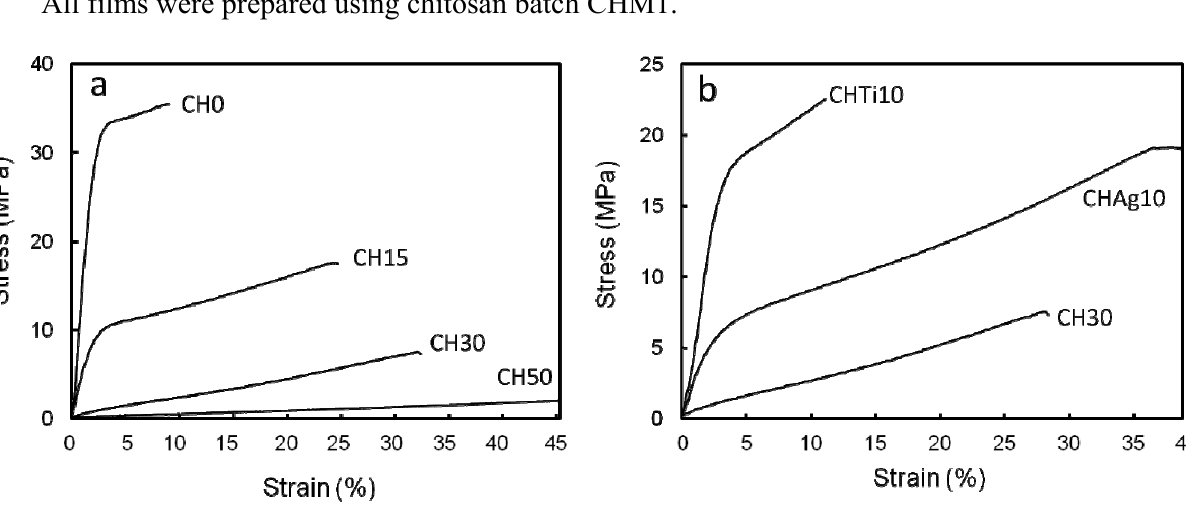
Figure 2. Stress-strain curves for typical chitosan (CH) and chitosan composite films. ( a ) comparison for glycerine content (by weight relative to CH) of 0% (CH0), 15% (CH15), 30% (CH30) and 50% (CH50); and ( b ) comparison between composite films (CHTi10) and Ag (CHAg10). The containing 10% (by weight relative to CH) of TiO 2 CHTi10 and CHAg10 films were prepared with 30% glycerine (by weight relative to CH). All films were prepared using chitosan batch